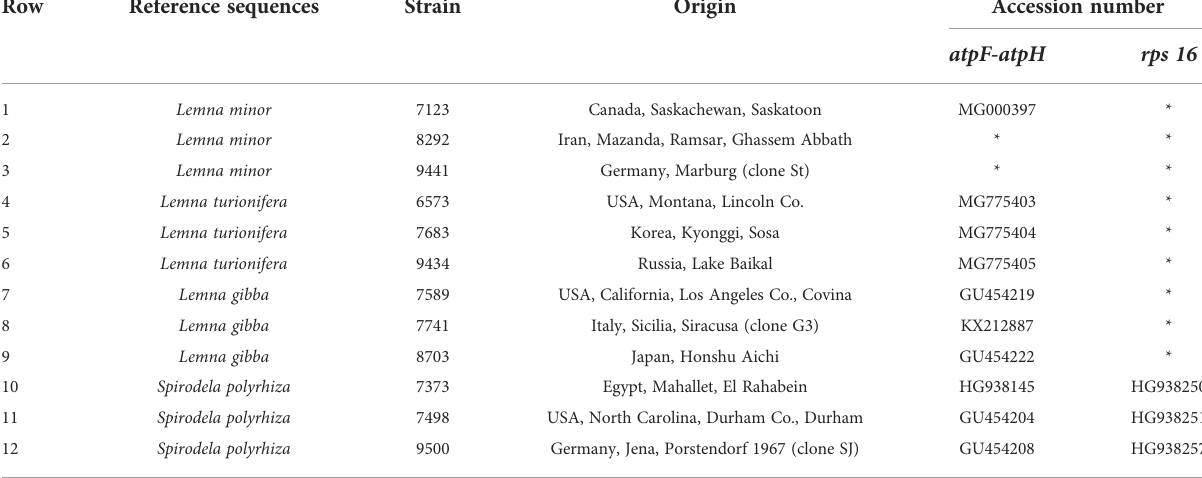
TABLE 2 Reference sequences of atpF-atpH and rps16 markers for DNA barcoding.